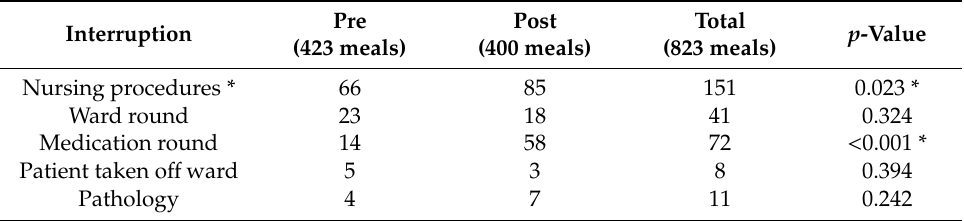
Table 4. Mealtimes interrupted pre and post